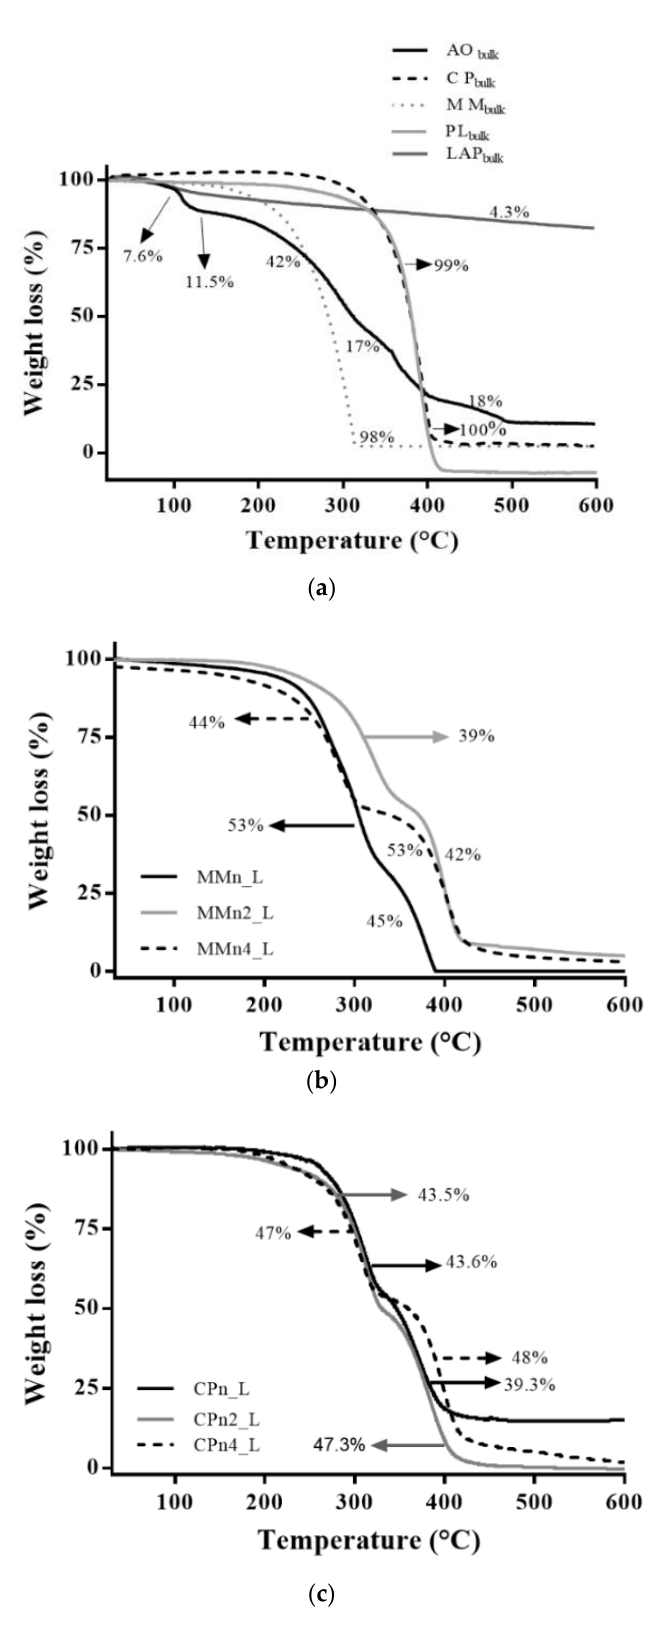
Figure 2. TG curves of hybrid system components AO, CP, MM, PL, and LAP ( a ), hybrid system prepared with MM ( b ) and CP ( c